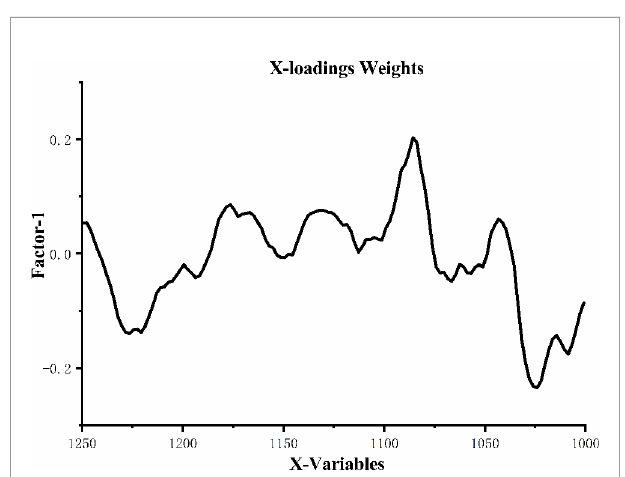
FIGURE 5 | Loading plot of